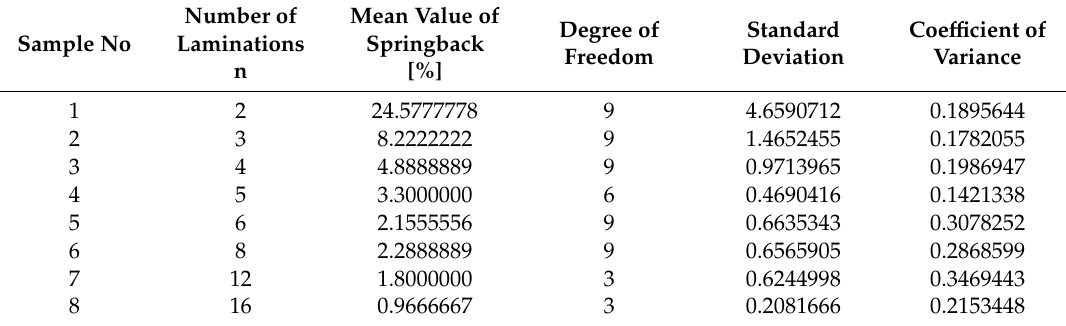
Table 2. Statistical analysis of the springback mean values of a number of laminations.